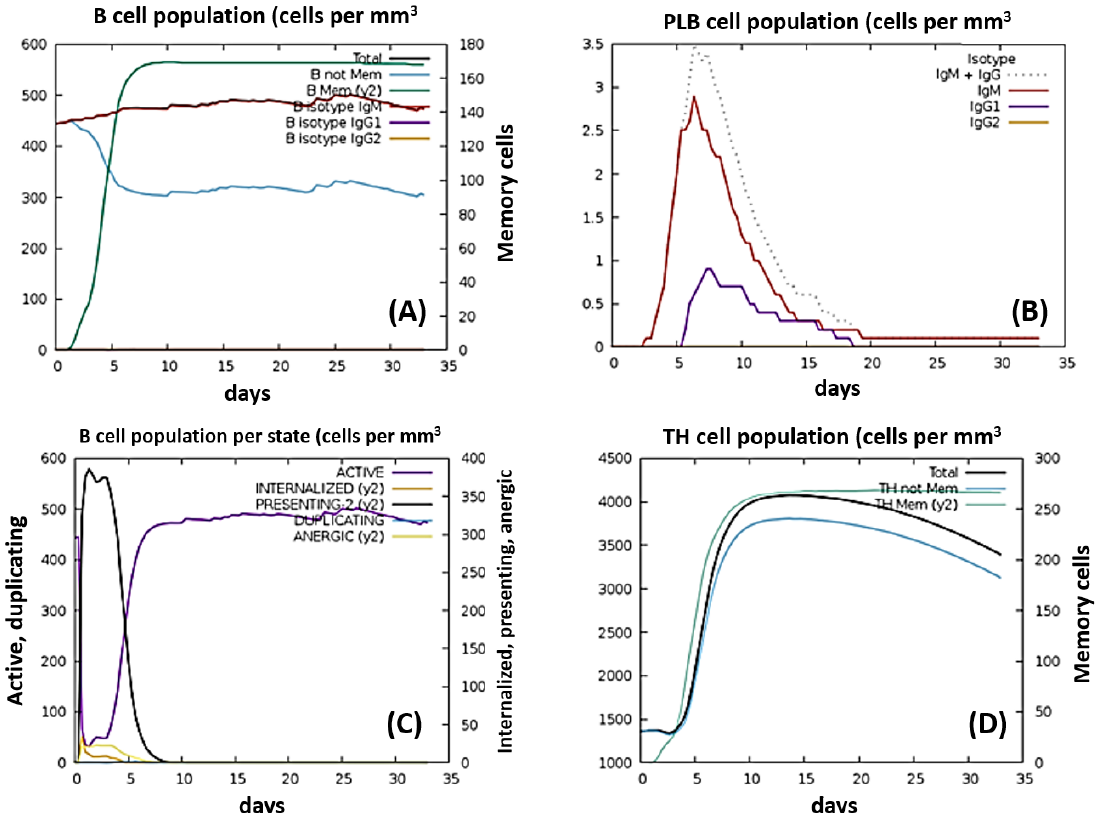
Figure 10. B- and T-cell populations upon vaccine injection: ( A ) antibody isotopes produced and activated in response to the vaccine, ( B ) PLB cells’ response against vaccine, ( C ) B-cell response per state, ( D ) helper T-cell response against the vaccine.